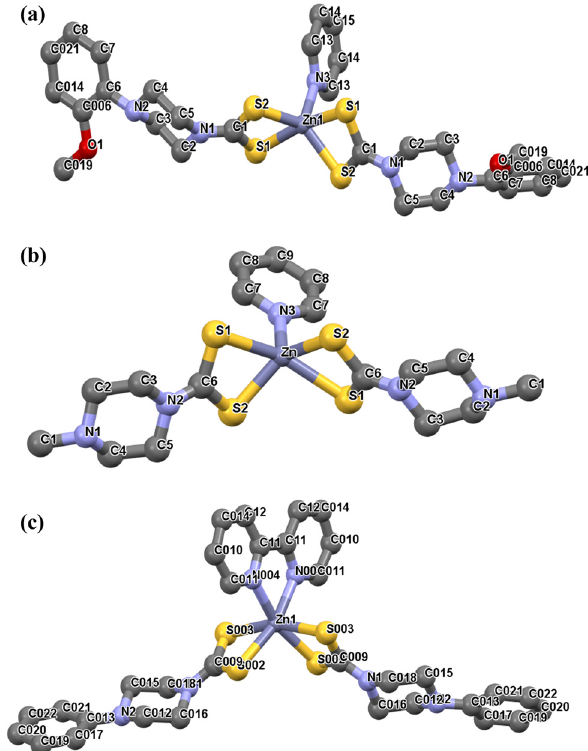
Figure 8: Molecular structure of ( a ) [ Zn ( 2 - mppdtc ) 2 ( py ) , ( b ) Zn ( mpdtc ) ( py ) , and ( c ) [ Zn ( ppdtc ) ( bipy )] . Redrawn from ref. [ 39 ] , 2 2 with permission from Elsevier ( Copyright 2020 )